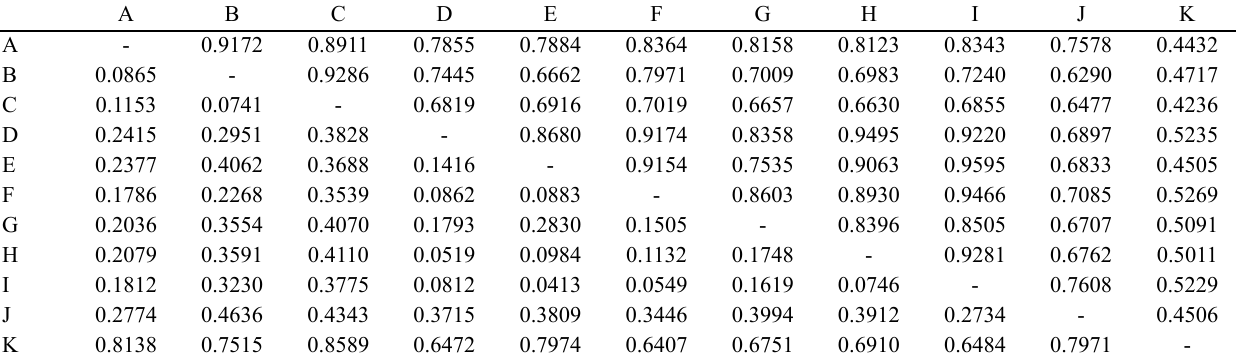
Table 4. Genetic distance value in 11 cattle population (unbiased measures of genetic identity and genetic distance based on Nei et al.